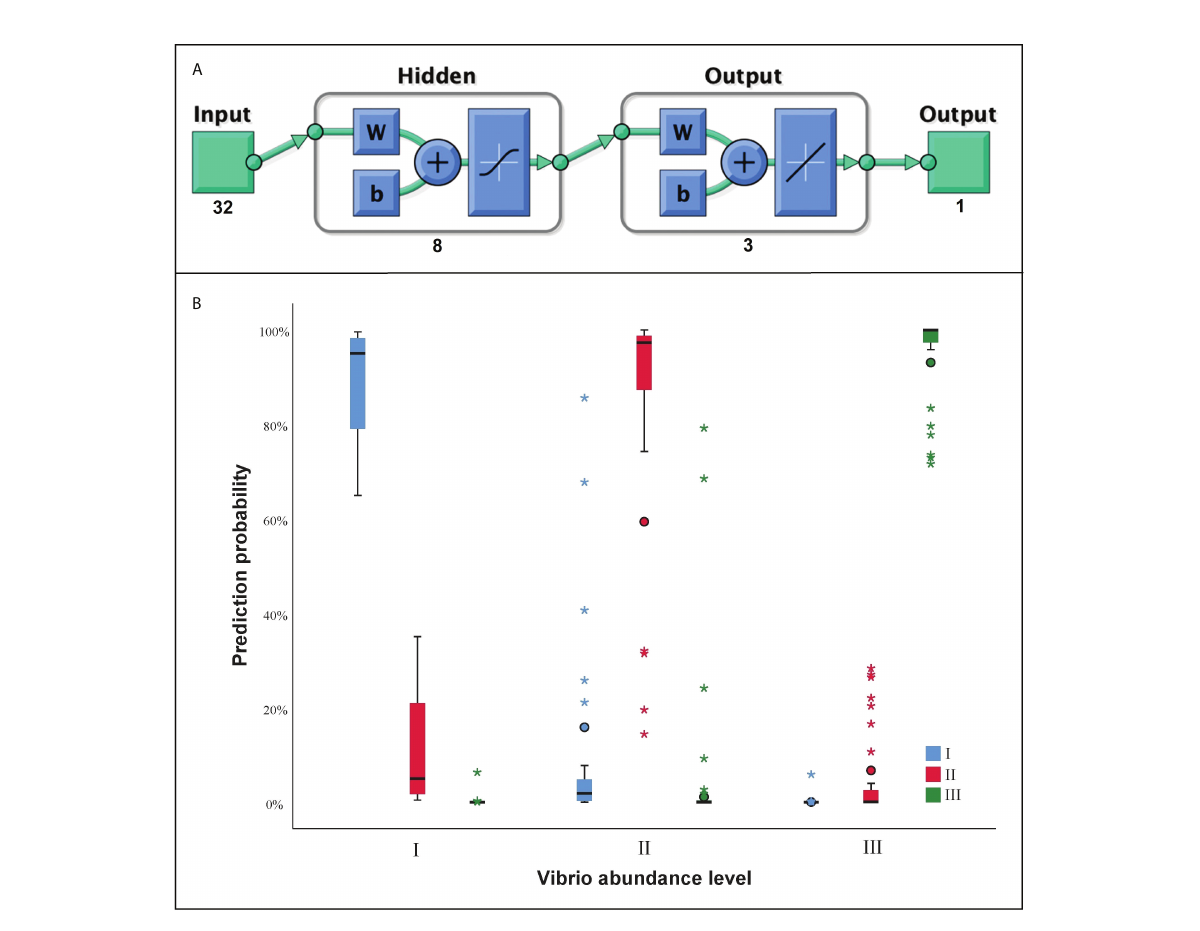
FIGURE 8 The arti fi cial neural network (ANN) for Vibrio abundance prediction. (A) The structure of ANN layer; (B) The prediction probability of ANN model at three abundance level of Vibrio . “ I, II, III ” indicate the three levels of